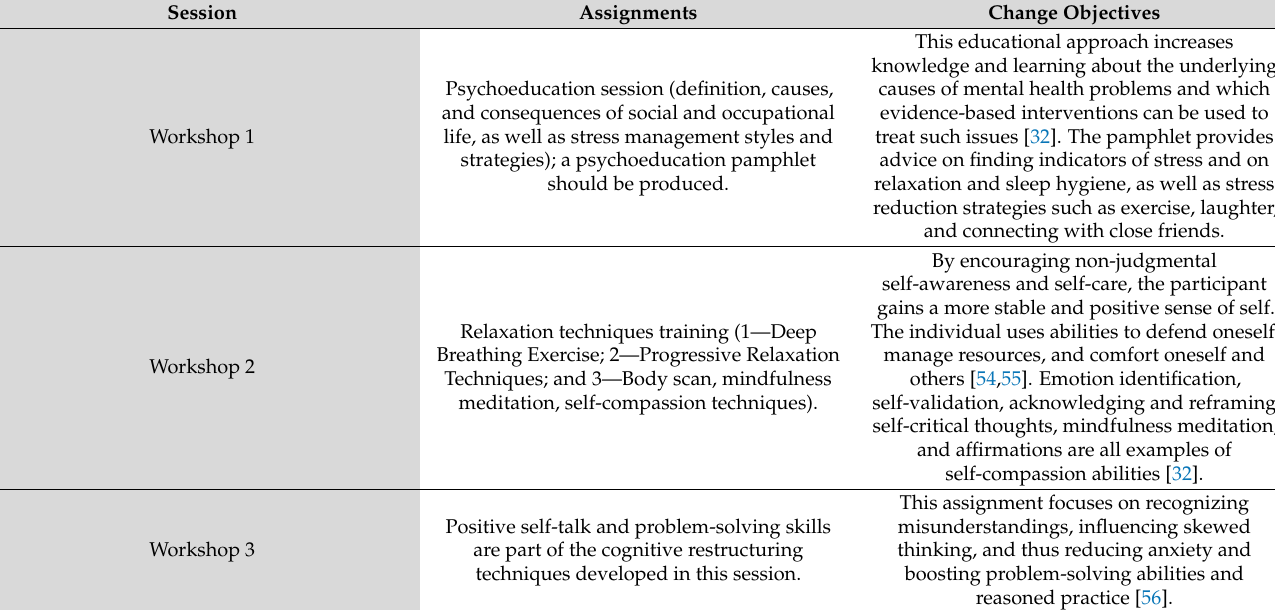
Table 5. The matrix of change objectives in the